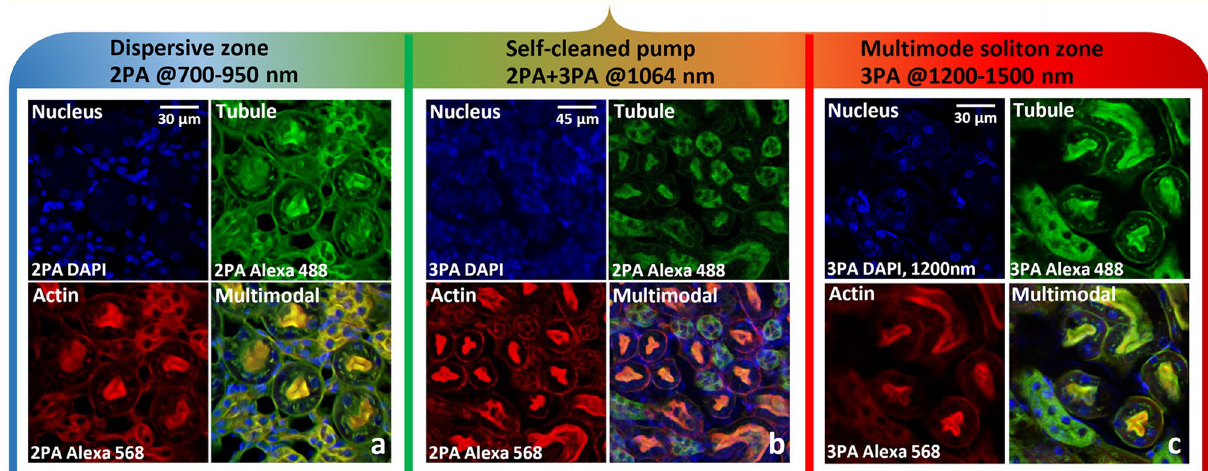
Figure 2. NF images of mouse kidney, labelled with Alexa 488, Alexa 568 and DAPI, revealing tubule, actin and nucleus, respectively. Microscopy configuration. ( a ) 2PA fluorescence imaging (tubule, actin and nucleus) by using visible/IR light (700–950 nm). ( b ) 2PA and 3PA (nucleus) imaging, by using a self-cleaned pump beam at 1064 nm. ( c ) 3PA imaging by using IR light (1300–1500 nm; 1200 nm for nucleus). Dwell time: 5 µs/px; averaged traces for 1 image: 20; image size: 1024 × 1024